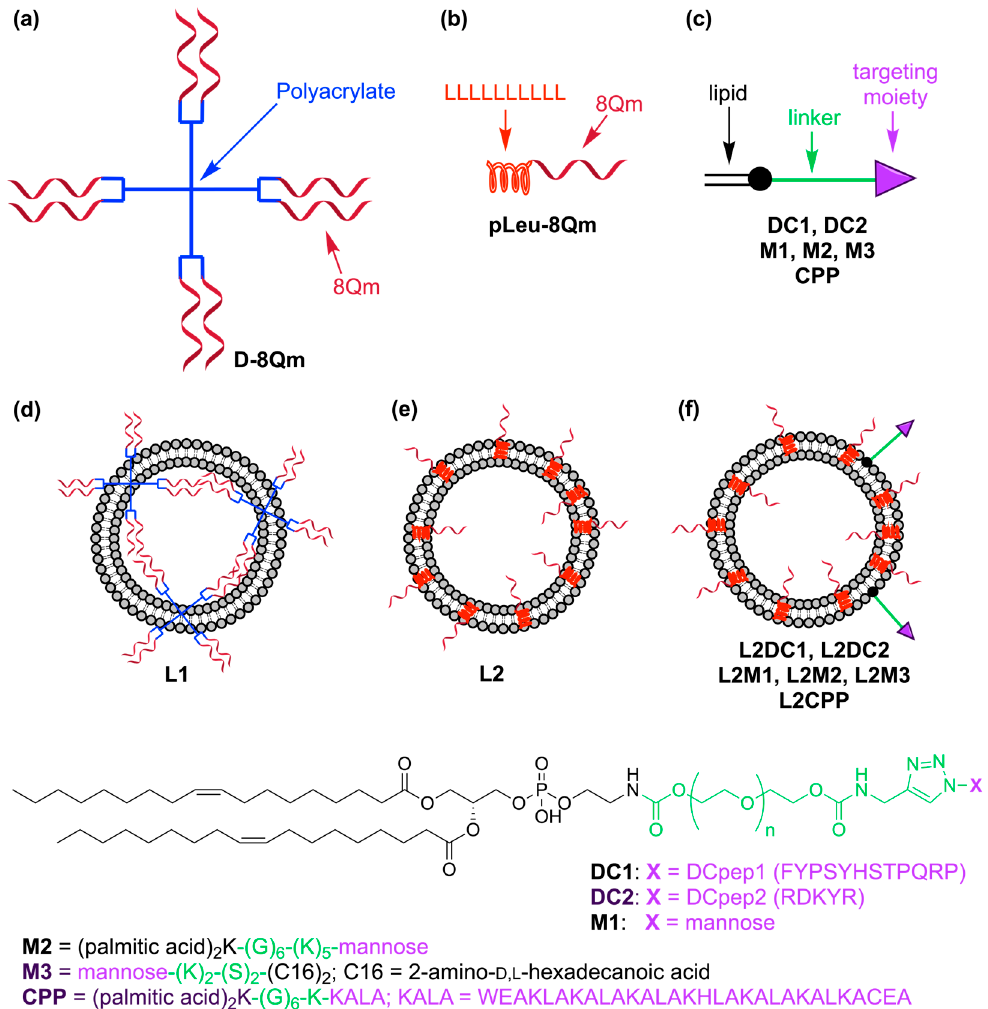
Figure 1. Schematic representation of the vaccine candidates used in the study: ( a ) D-8Qm ; ( b ) pLeu- 8Qm ; ( c ) DCs-targeting moieties and liposomes; ( d ) L1 bearing D-8Qm ; ( e ) L2 bearing pLeu-8Qm ; and ( f ) L2M bearing pLeu-8Qm and targeting moieties. Peptide sequences are shown with their one-letter amino acid code.